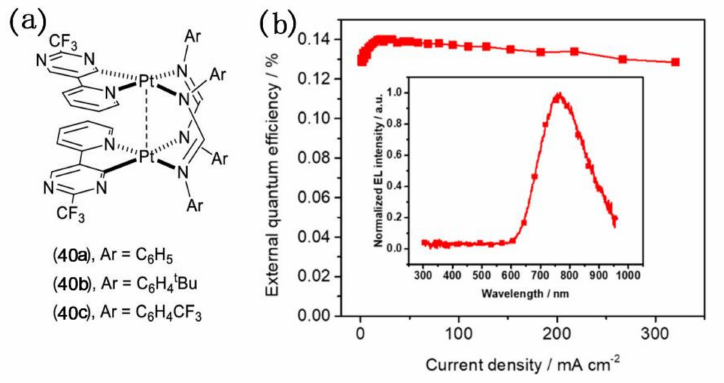
Figure 15. ( a ) The structure of 40a – 40c ; ( b ) EQE curves of organic light-emitting diodes (OLED) with 40b as the non-doped emitter. Inset: EL spectra of OLED. Reprinted with permission from [77]. Copyright 2019, American Chemical